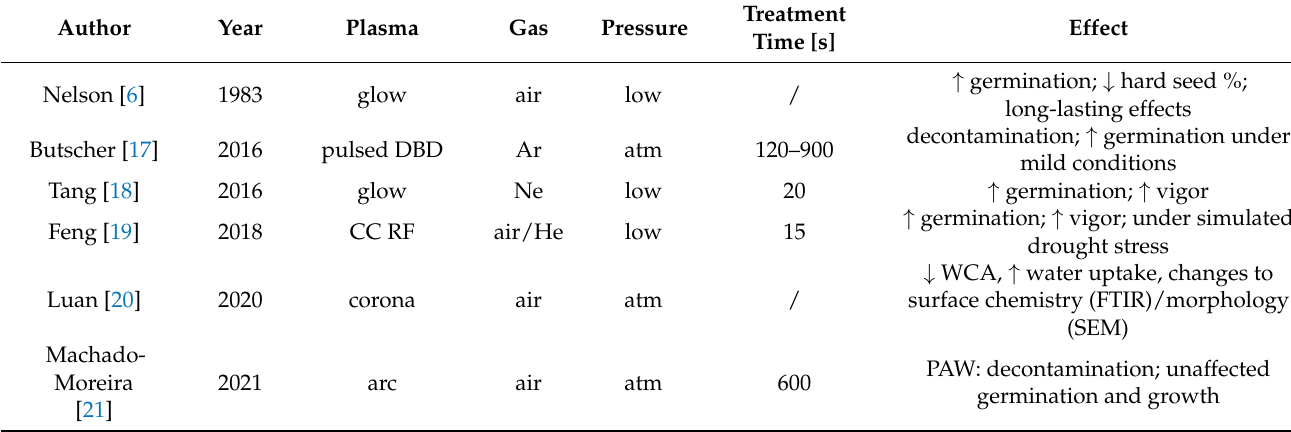
Table 1. Overview of currently available research concerning the treatment of alfalfa seeds with gaseous